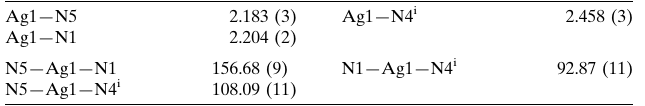
Selected geometric parameters (A ˚ , (cid:4) ).